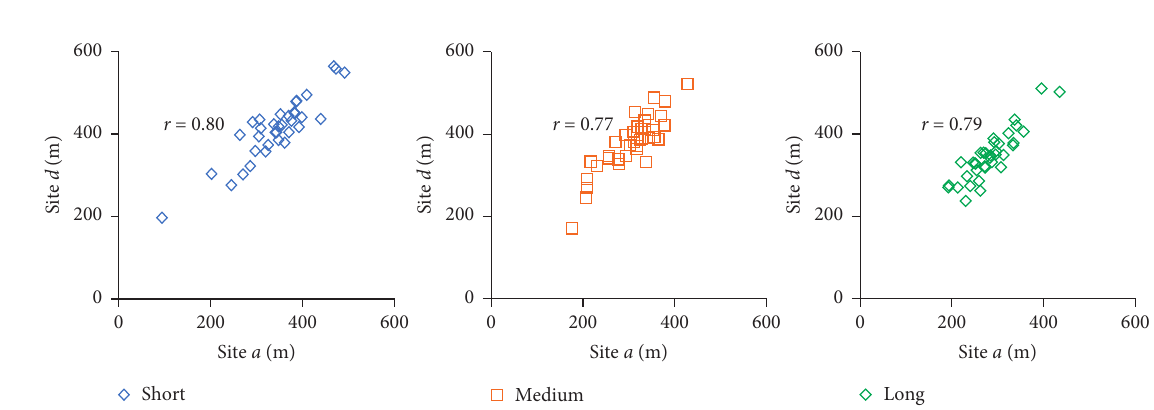
Figure 11: Correlation of sites a and d under three tunnel